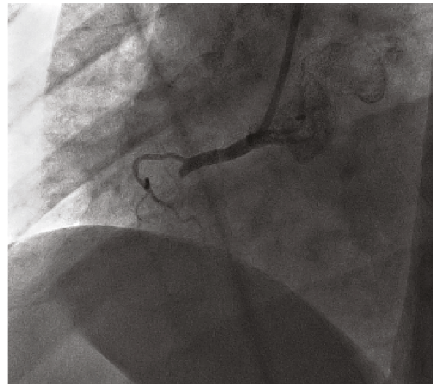
Figure 4: Chronic total occlusion (CTO) of the proximal right coronary artery (RCA)